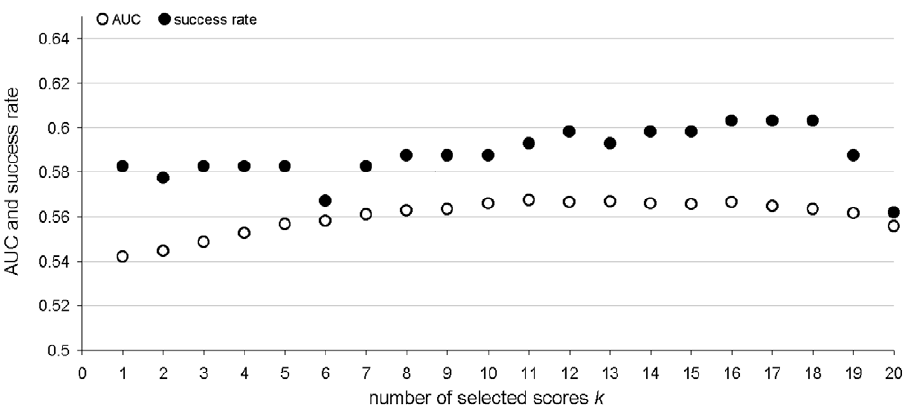
Figure 4. The AUC and success rate values in the function of the number of selected scores k ( x -axis) when using SVM model with 84 features and the distancescheme to predict B-cell epitopes on the SEQ194 dataset. We use the Filtered40_BCPREDFrag to generate the